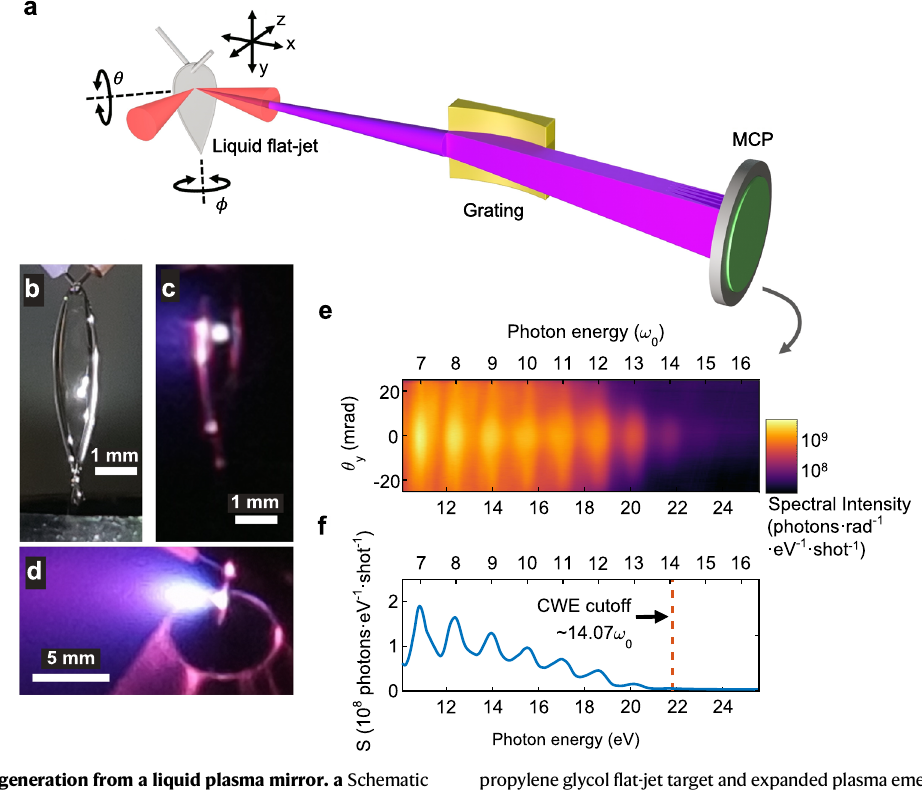
propyleneglycol fl at-jettarget and expanded plasmaemerging along thedirection normalto the liquid sheet. e Typicalangle-resolved spectrum of CWEfrom aliquid plasma mirror. The plot is coloured in the logarithmic scale. f Spectrum of CWE obtained by integrating the divergence angle of the spectrum shown in e